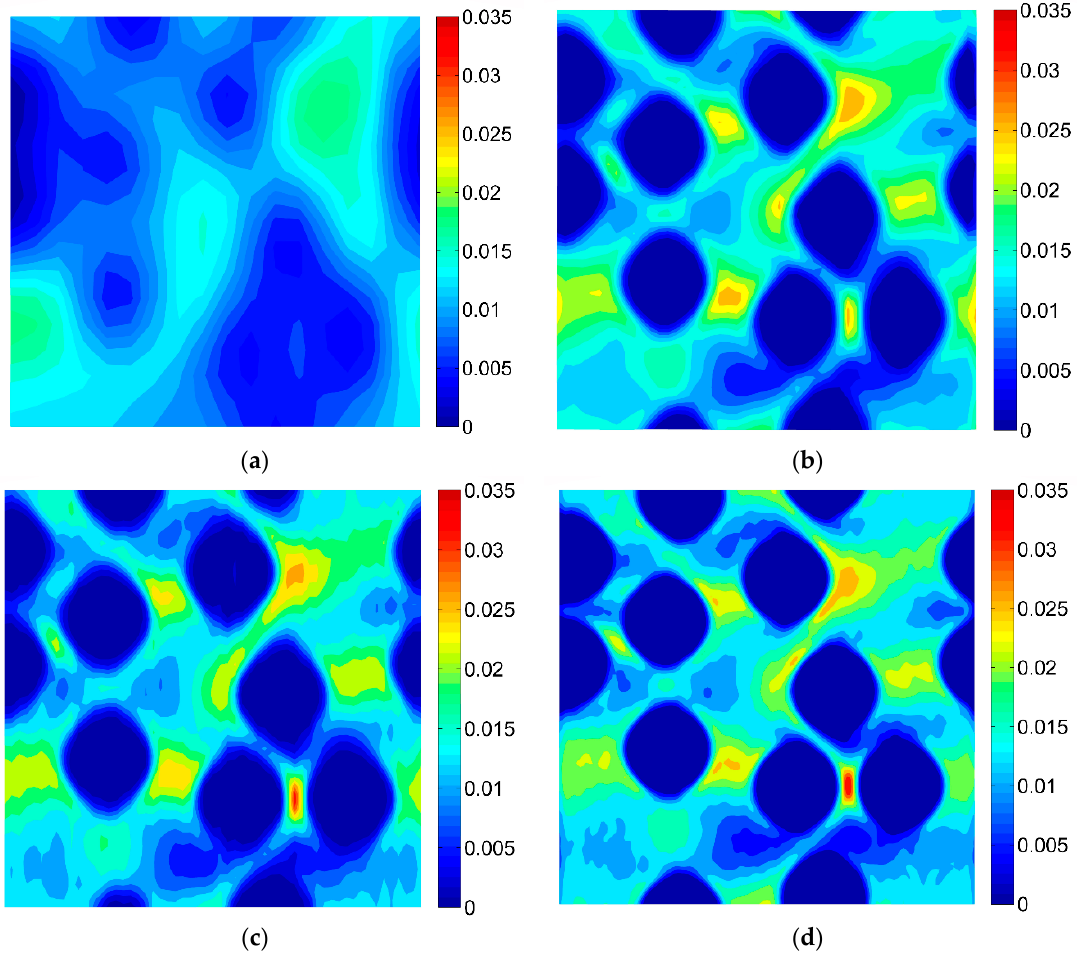
Figure 13. Distribution of strain ε 11 obtained for Material 2 with consideration of different speckle sizes, grid of squares: ( a ) 50 × 50, ( b ) 100 × 100, ( c ) 150 × 150, ( d ) 200 × 200.